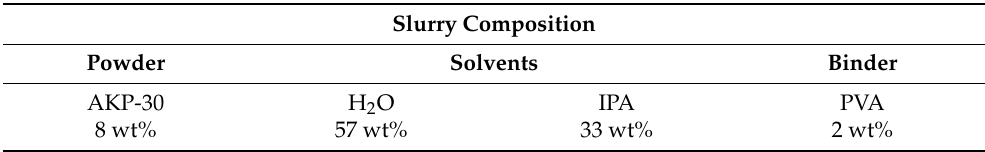
Darvan-CN added as a